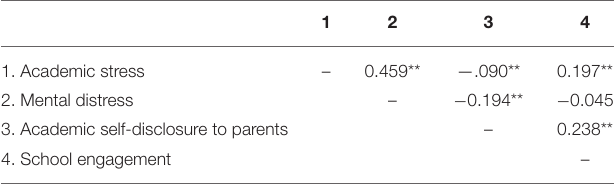
TABLE 2 | Intercorrelations between variables.